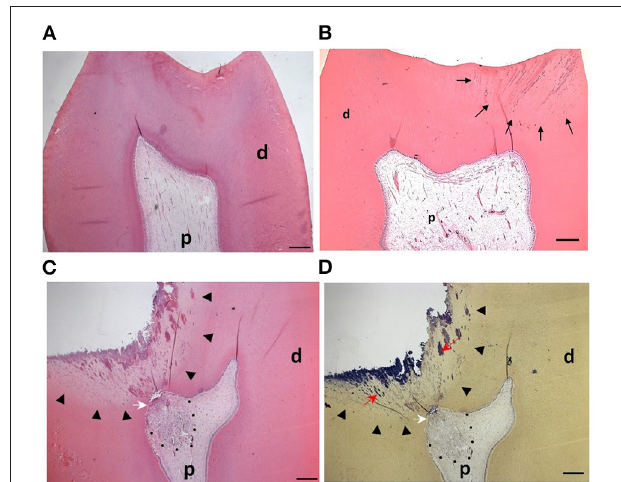
FIGURE 2 | Pulp response to caries progression: (A) H&E staining of the dental pulp from a sound molar tooth showing healthy tissue with an intact odontoblast layer (B) In shallow caries bacteria and their components (black arrows) diffuse through dentinal tubules but have not reached the pulp. The odontoblast layer remains intact and the pulp tissue responds with formation of reactionary dentine. (C) In deep caries there is a more pronounced inflammatory response to the increased levels of infiltrating bacteria within the dentine (arrowheads). The dentine structure is irregular, partially destroyed and exhibits a non-tubular morphology. Reparative dentine (white arrow) is deposited beneath the carious lesion and there is an apparent and localized inflammatory cell infiltrate (dotted line). (D) Brown and Brenn staining of cariogenic bacteria (red arrows) in the same section as is shown in (C) . P = pulp, d = dentine. Figure adapted from El Karim et al. (61), J Endod. Permission obtained from